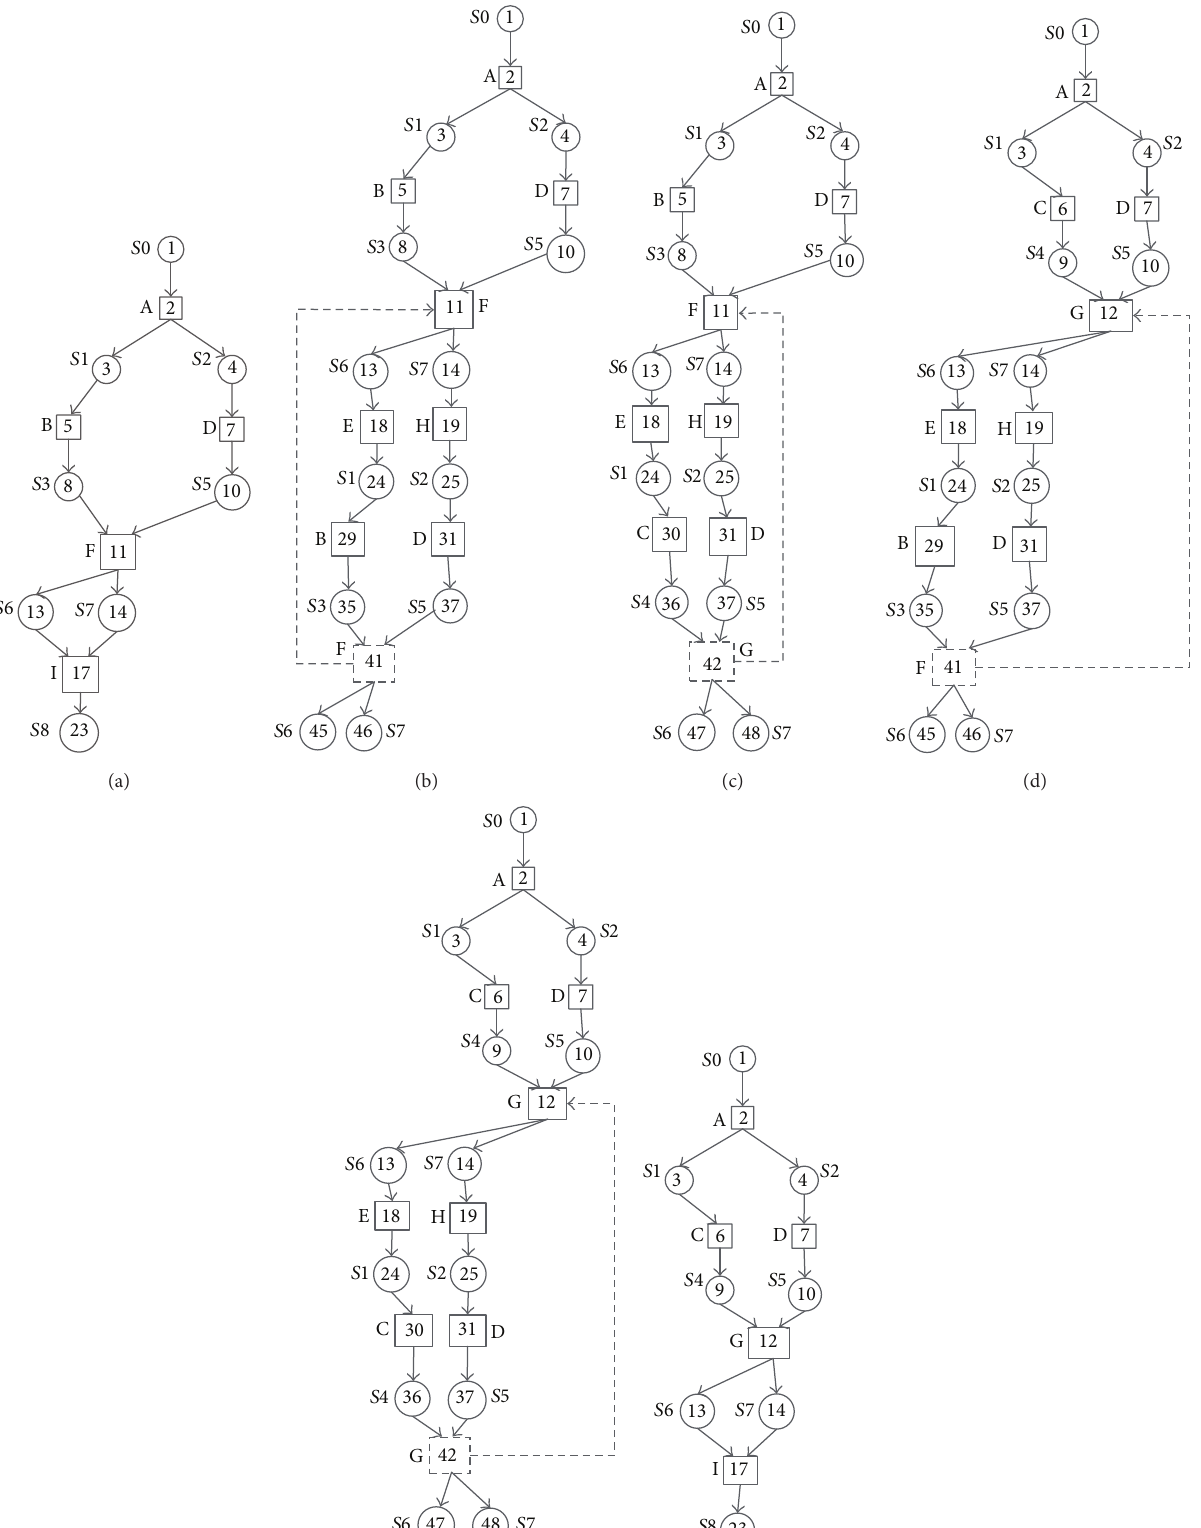
Figure 7: The set of conflict-free annotated CFPs transformed from Fin 𝑎 Σ in Figure 5(c) according to Algorithm